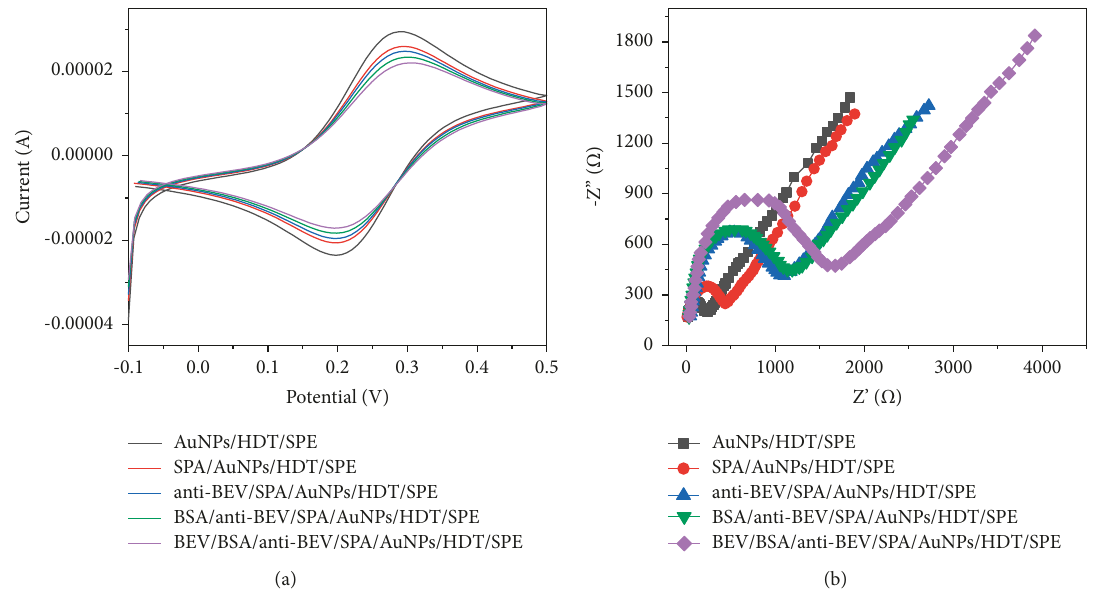
Figure 3: (a) CV curves and (b) EIS spectra of AuNPs/HDT/SPE, SPA/AuNPs/HDT/SPE, anti-BEV/SPA/AuNPs/HDT/SPE, BSA/anti- BEV/SPA/AuNPs/HDT/SPE, and BEV/BSA/anti-BEV/SPA/AuNPs/HDT/SPE in 5mM [Fe(CN)6] 3-/4- (0.1M PBS).